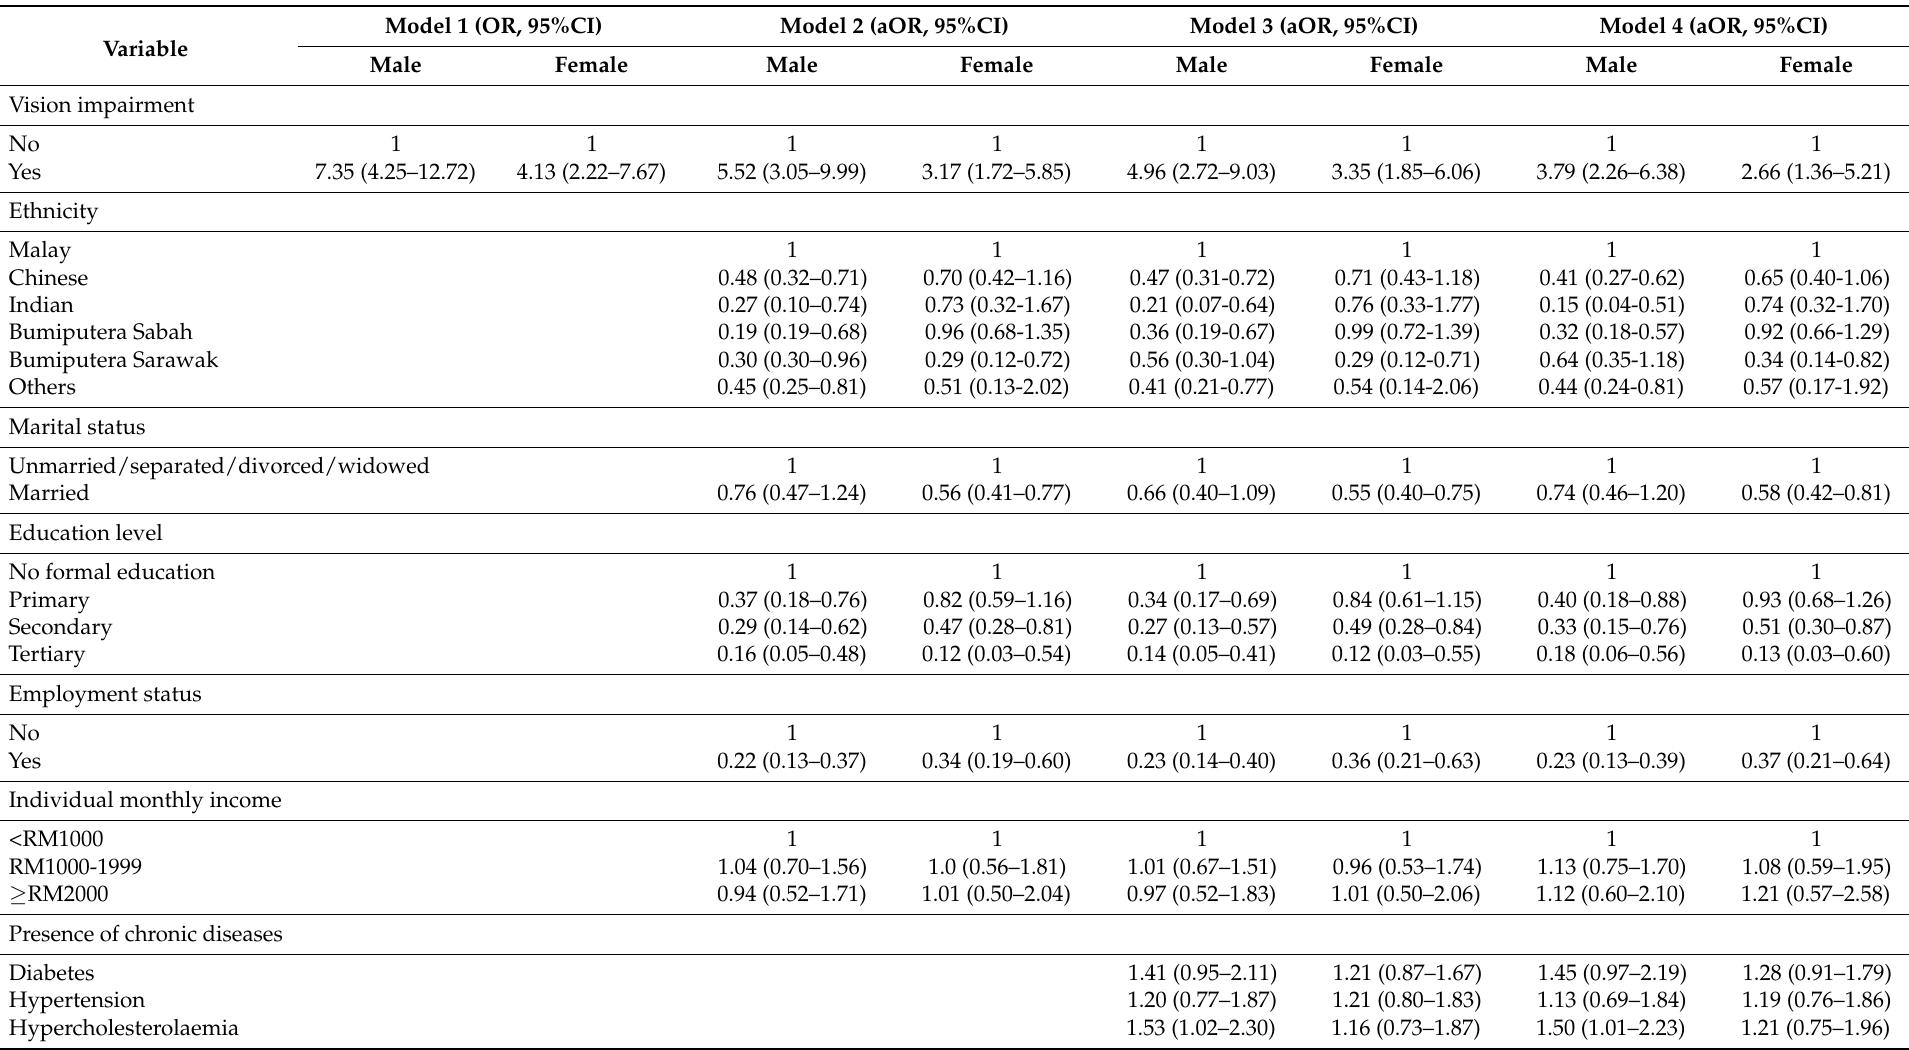
Table 2. Unadjusted and adjusted associations between vision impairment and ADL